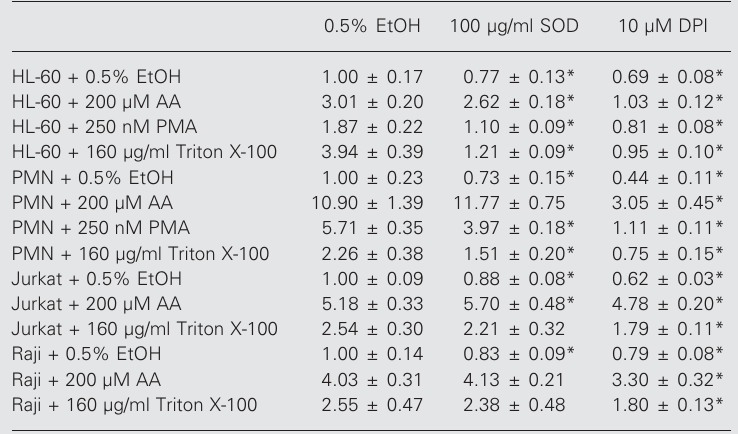
Table 1. Inhibition of nitroblue tetrazolium reduction by superoxide dismutase and